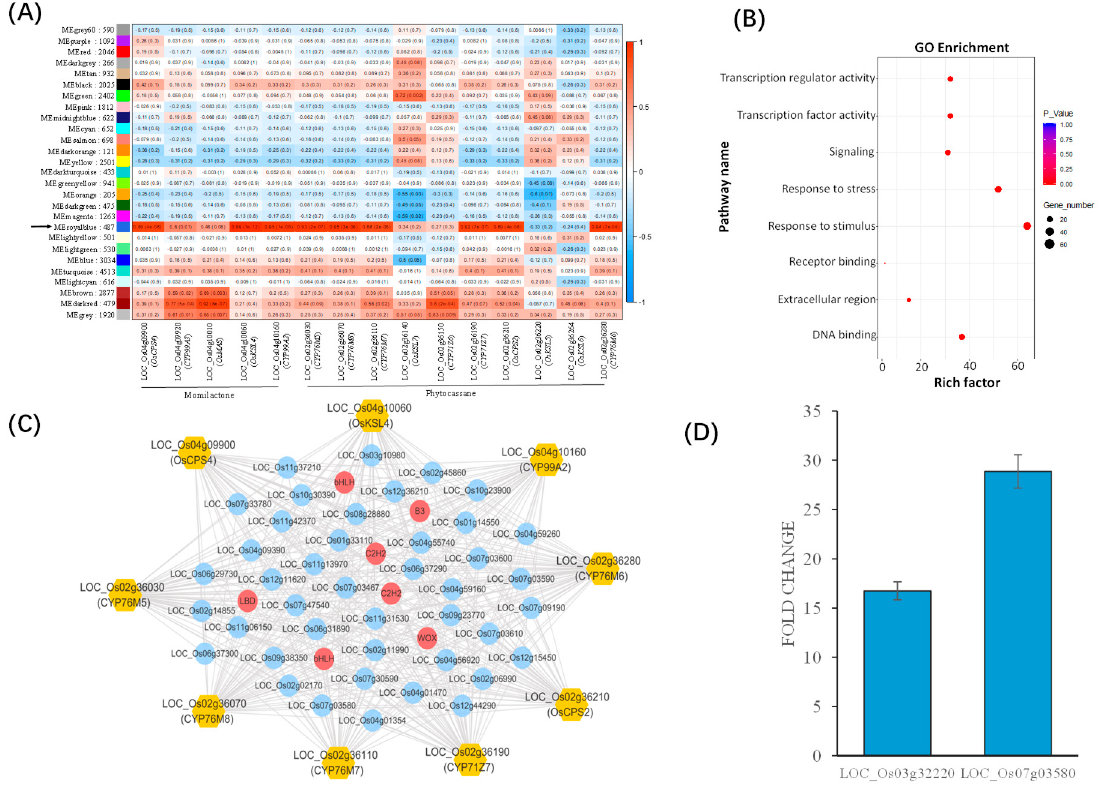
Figure 3. One gene module co-regulated with the two biosynthetic gene clusters in rice. ( A ) The relationship between the 27 gene modules with genes in the momilactone and phytocassane gene cluster in barnyardgrass. Each row corresponds to a module eigengene (correlation between a column and a trait). Each cell contains the corresponding correlation e ffi cient and p -value. The arrow indicates the most highly co-expressed ‘MEroyalblue’ module. ( B ) GO enrichment result for the genes in the ‘MEroyalblue’ module. ( C ) The gene co-expression network among the hub genes from the ‘MEroyalblue’ module with genes in the momilactone and phytocassane gene clusters. Transcription factors are colored in red. ( D ) Gene expression changes of the two rice hub genes after co-cultured with barnyardgrass. Expression value of genes without co-cultured with barnyardgrass was normalized to be one. Three biological replicates were used in the experiment.